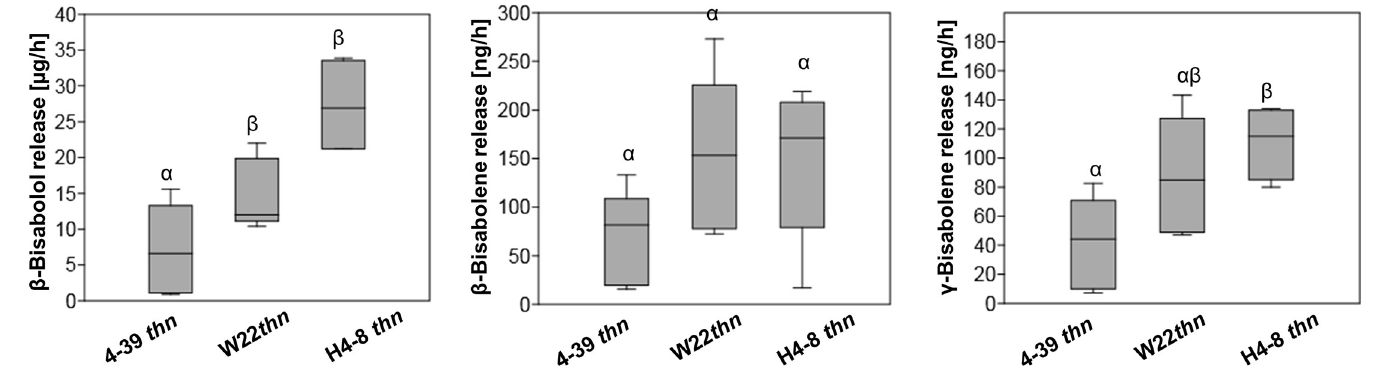
Fig 5. Quantification of sesquiterpenes from S . commune thn colonies pre-grown for 5 days on CYM. P < 0.05, n = 5.